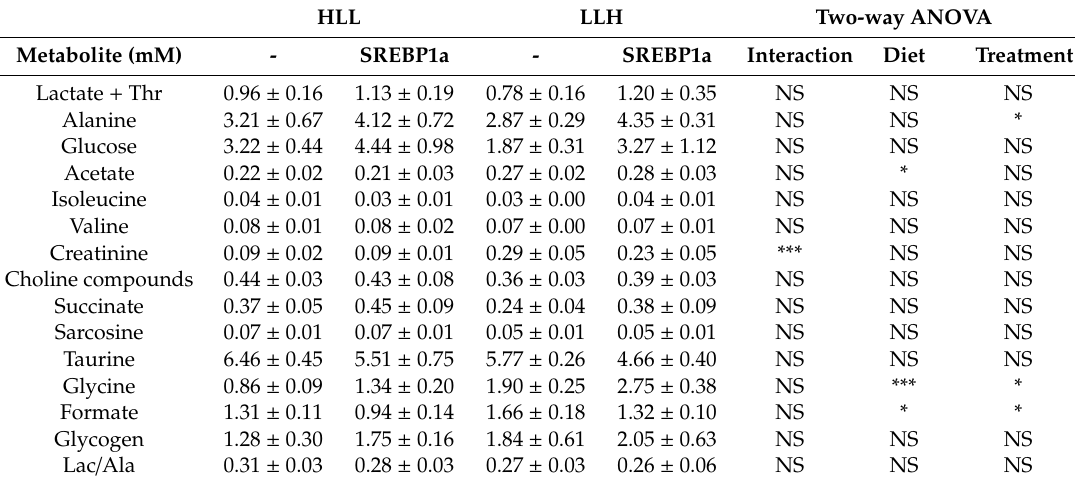
Table 3. Effect of SREBP1a overexpression on aqueous metabolites in the liver of S. aurata .